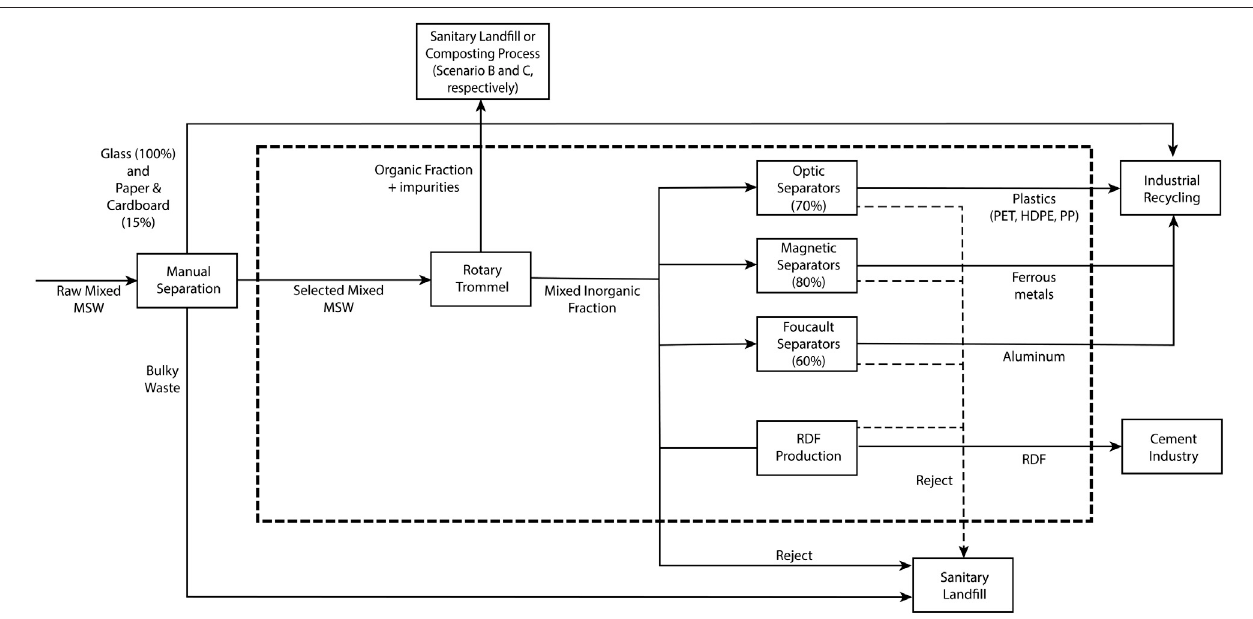
FIGURE 3 | Mechanical treatment plant fl ow diagram considered for scenarios B and C. The percentage below each separation unit represents its ef fi ciency. The dashed line represents the boundaries of the MT plant (SEMADET, personal communication, 2020).